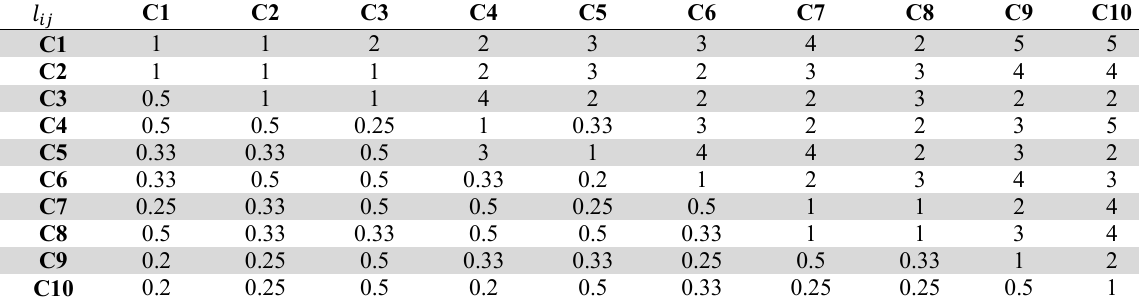
Lower bound of lexicographic decision